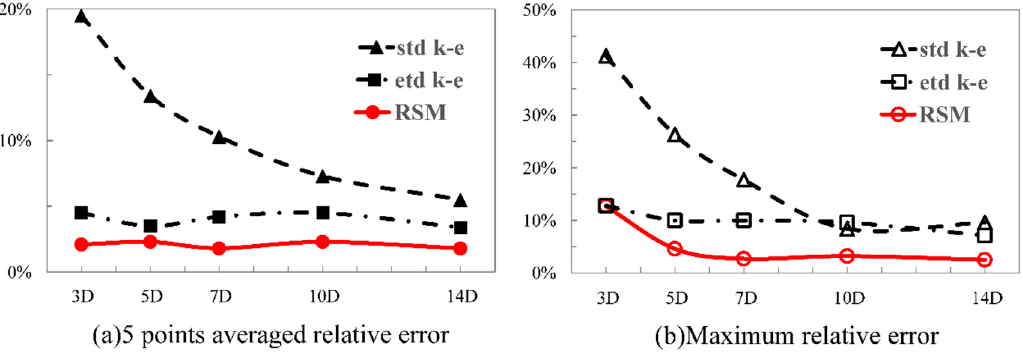
Figure 7. Simulation’s relative error of velocity, ( a ) 5 points averaged relative error; ( b ) maximum relative error.